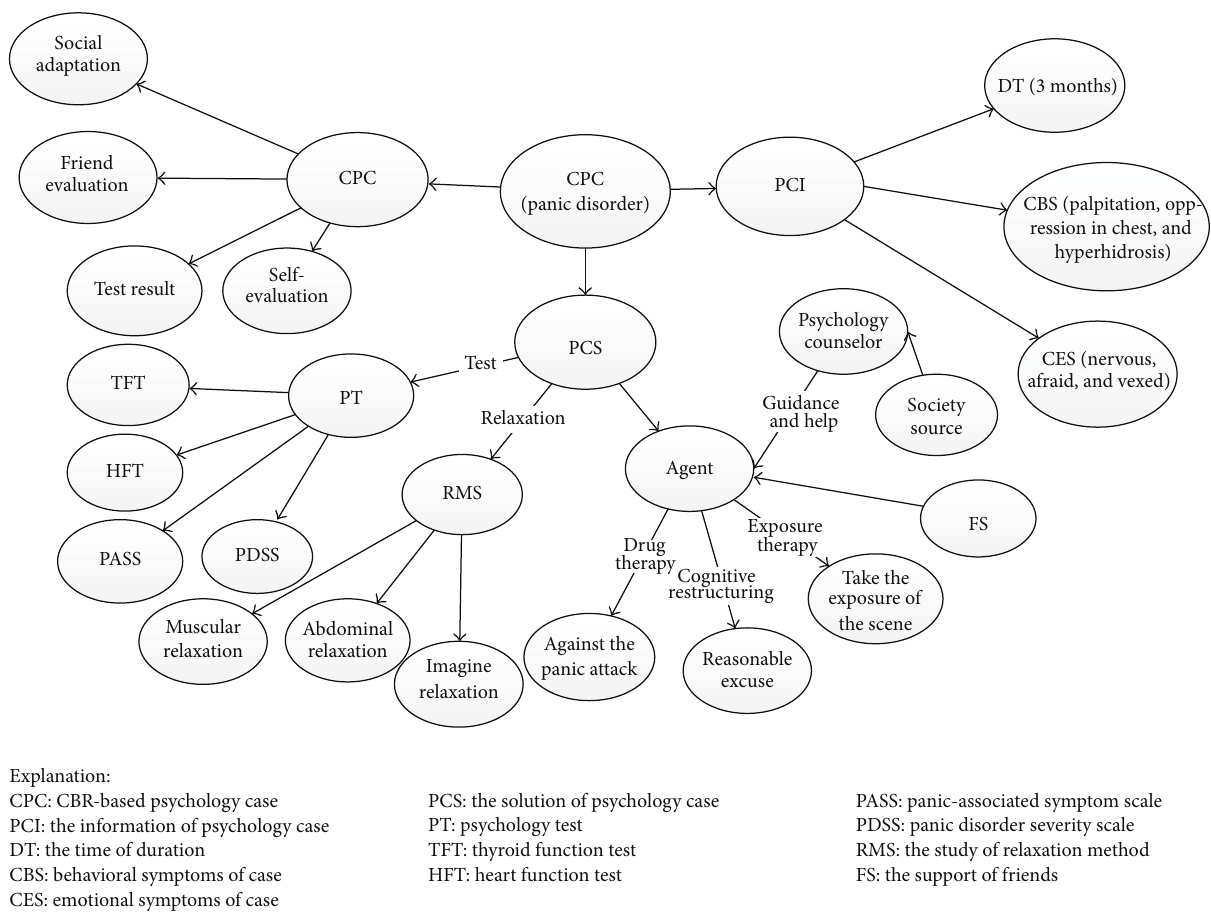
Figure 1: The fragments of knowledge that are caused by the event of panic disorder.